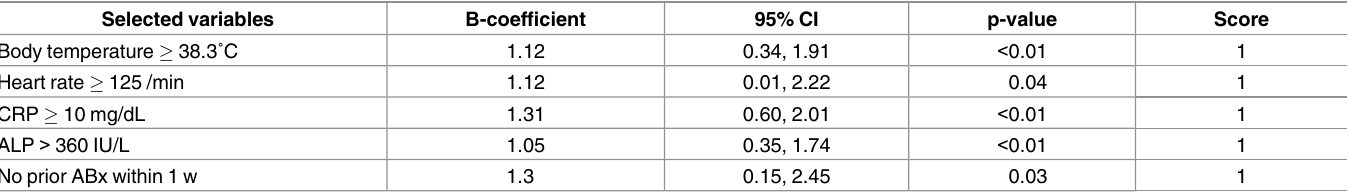
Table 3. Multivariate analysis and scoring.